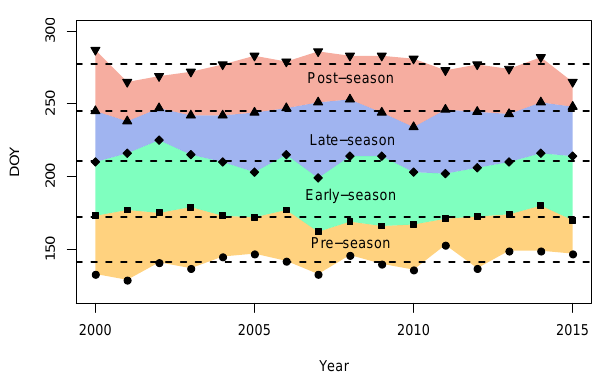
Figure 3. Interannual variability of all key dates with symbols marking the exact date, with lines indicating the overall mean and colored areas representing the resulting sub-season during the grow- ing season. Key dates from bottom to top: start of pre-season (cir- cle), SOS (rectangle), POS (diamond), EOS (standard triangle), and end of the post-season (upside-down triangle). Due to cloud cov- erage, in 2012 the MODIS data coverage was not high enough to determine the key dates (SOS–POS); these dates are therefore lin- early